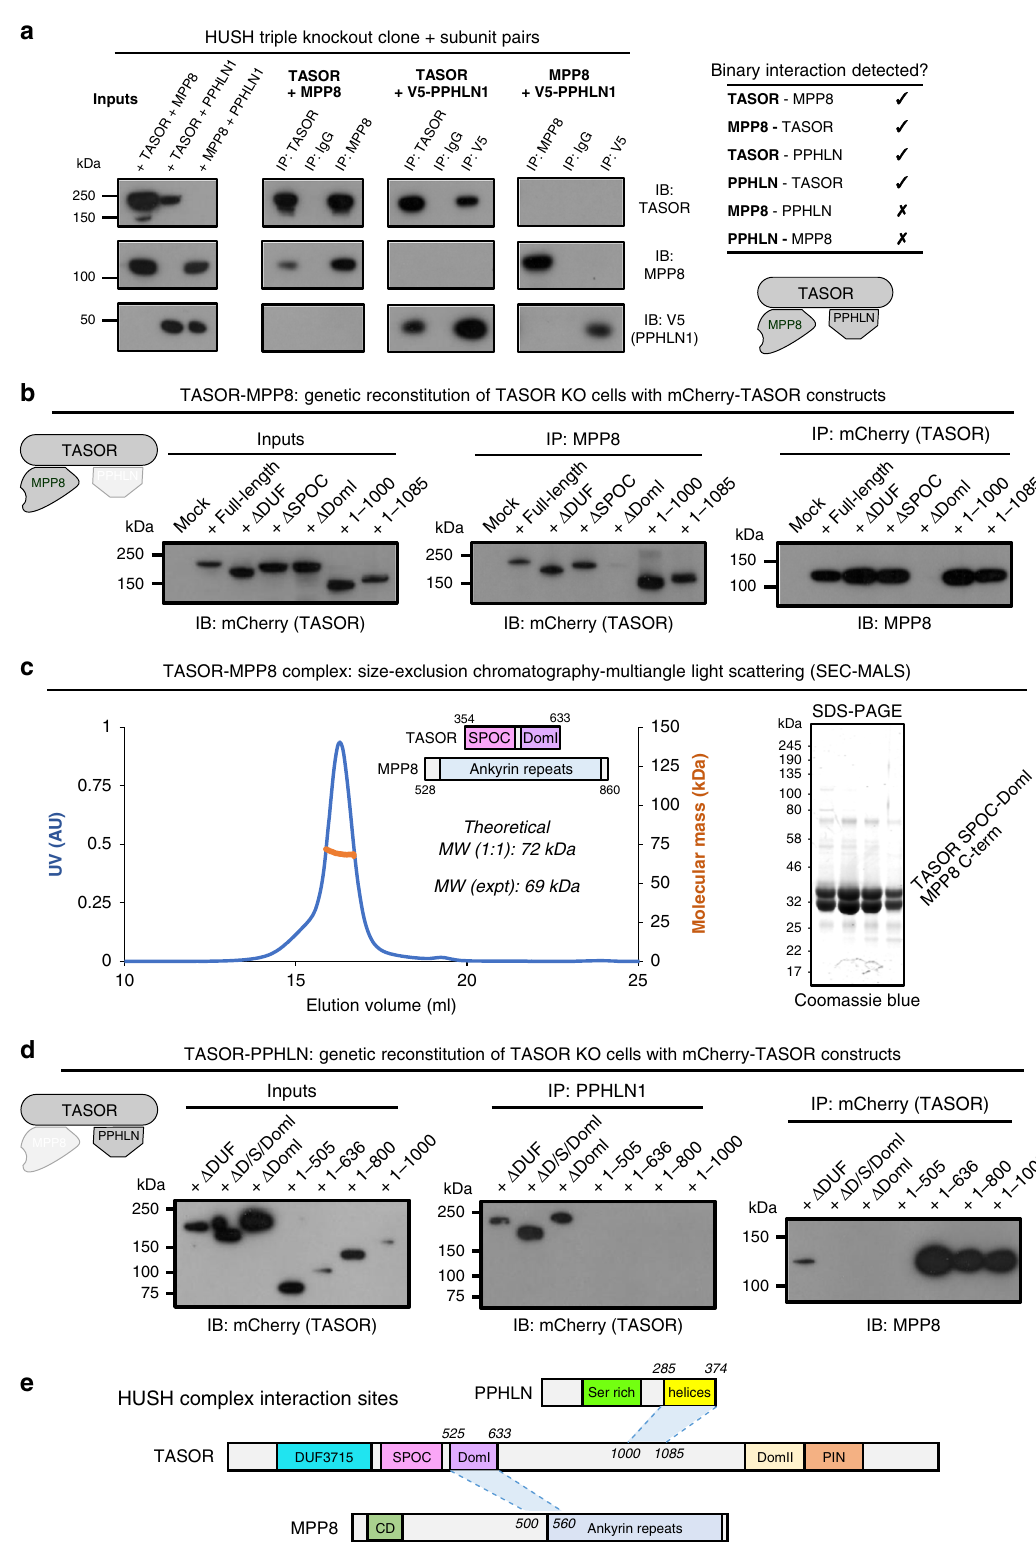
Fig. 3 TASOR lies at the heart of the HUSH complex. a TASOR interacts separately with MPP8 and Periphilin to mediate assembly of the HUSH complex. Pairwise combinations of HUSH subunits were exogenously expressed in HUSH triple KO cells, and interactions detected by co-immunoprecipitation (co- IP) followed by immunoblot. b TASOR DomI mediates the interaction with MPP8. The indicated TASOR truncation mutants were exogenously expressed in TASOR KO cells and their association with endogenous MPP8 assessed by co-IP. c SEC-MALS of recombinant TASOR(354 – 633)-MPP8(528 – 860) complex (theoretical MW, 72 kDa for a 1:1 complex) with representative SDS-PAGE gel of SEC peak fractions (inset). d The central linker of TASOR mediates the interaction with Periphilin. e Summary of core HUSH interaction